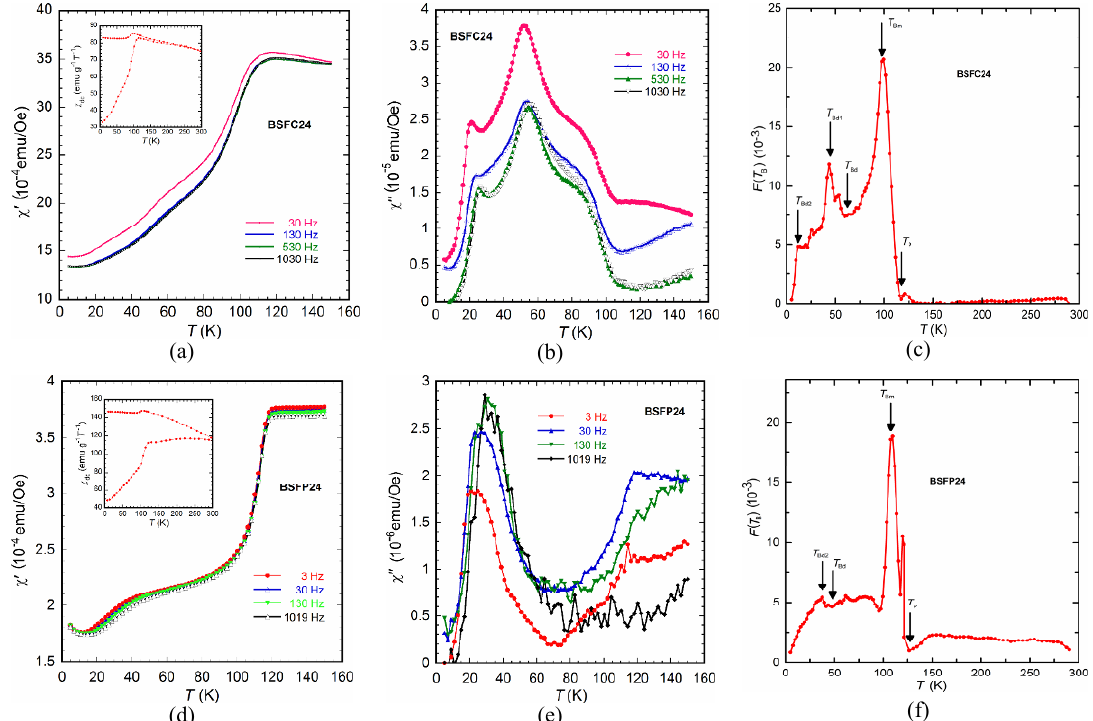
Fig. 5 AC magnetic susceptibility of BSFC24 (upper panels): (a) temperature dependence of the real part  . Inset: DC susceptibility. (b) Temperature dependence of the imaginary part  . (c) Temperature dependence of the distribution function ( ) F T . And BSFP24 samples (lower panels), as measured at different frequencies. (d) Temperature dependence of the real part   . B Inset: Temperature dependence of DC susceptibility. (e) Temperature dependence of the imaginary part   . (f) Temperature dependence of the distribution function ( ) F T B